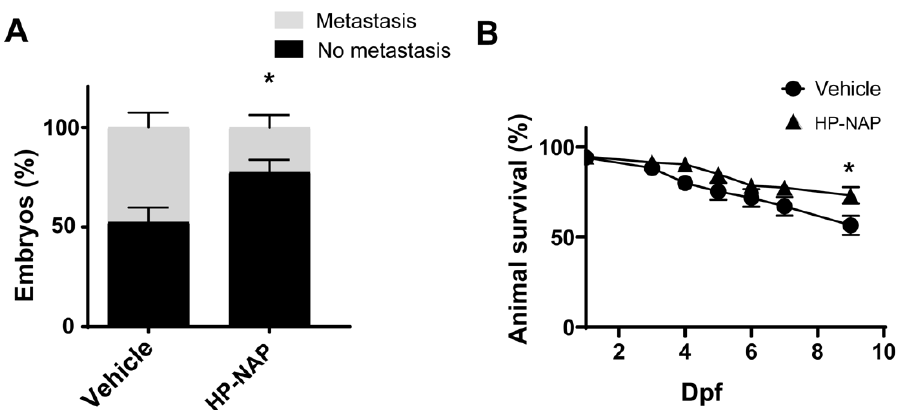
Figure 2. Effect of HP-NAP on melanoma metastasis and survival in zebrafish model. Fishes were treated as reported in Figure 1A. ( A ) The number of larvae with or without metastasis was counted at 9 dpf/7 dpi and expressed as percentage of the total embryos’ population. Values are expressed as mean ± SEM and analyzed by two-way ANOVA; *, p < 0.05; n = 150 fishes for each treatment. ( B ) Kaplan-Meier survival curves of animals treated with HP-NAP vs. vehicle; n = 50 fishes for each treatment. The Log Rank test was used for statistical analysis. *, p < 0.05.